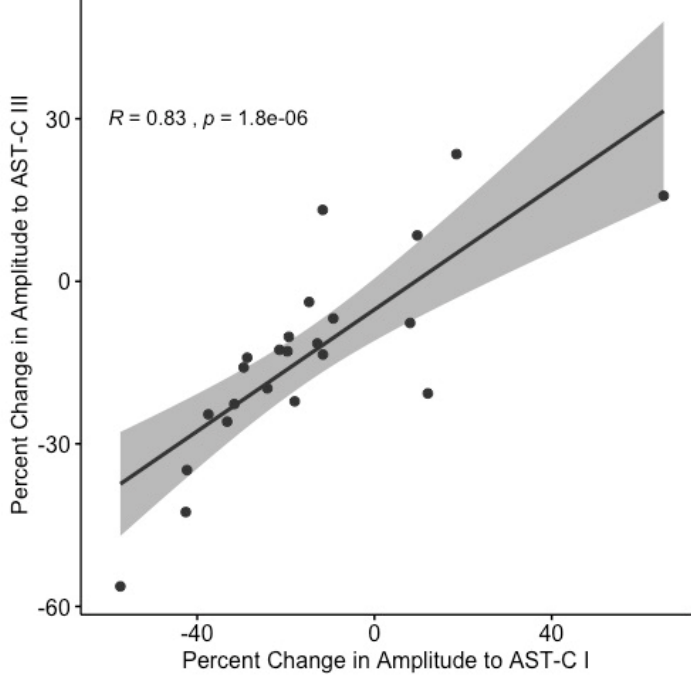
Figure 7. Physiological responses of individual lobsters to AST-C I and AST-C III are strongly positively correlated (Spearman correlation, R = 0.83, p < 0.0001). Physiological responses were measured as percent change in contraction amplitude in response to perfusion of the peptide. RNA for sequencing was extracted from the CGs of the lobsters used in this analysis. One outlier was omitted using the GraphPad Prism ROUT method ( n = 23).